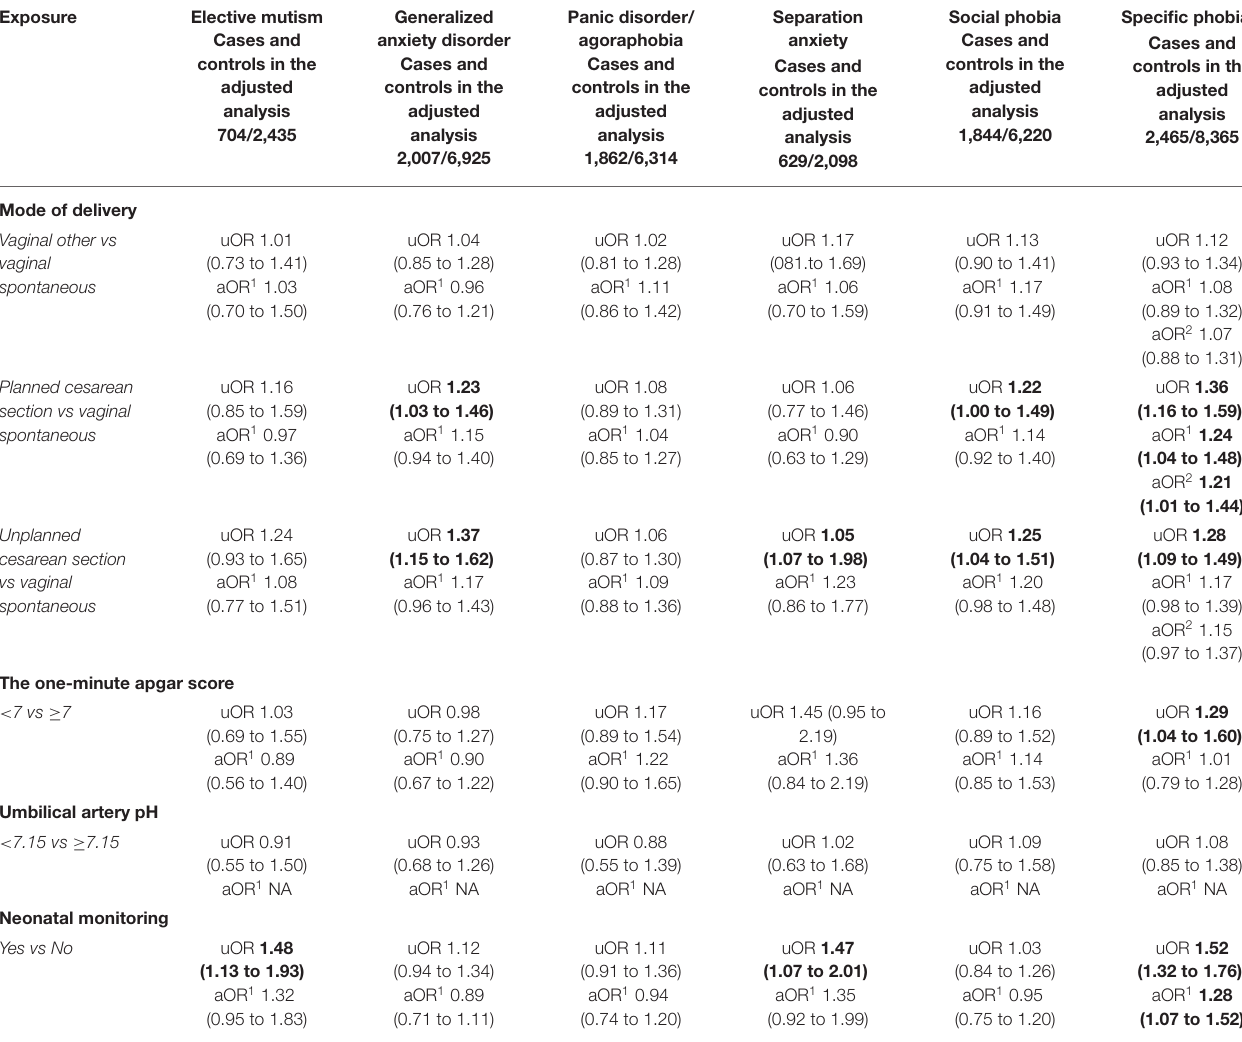
TABLE 2B | ORs (95% CIs) for the associations between the exposures and specific anxiety disorders in the unadjusted and adjusted analyses.